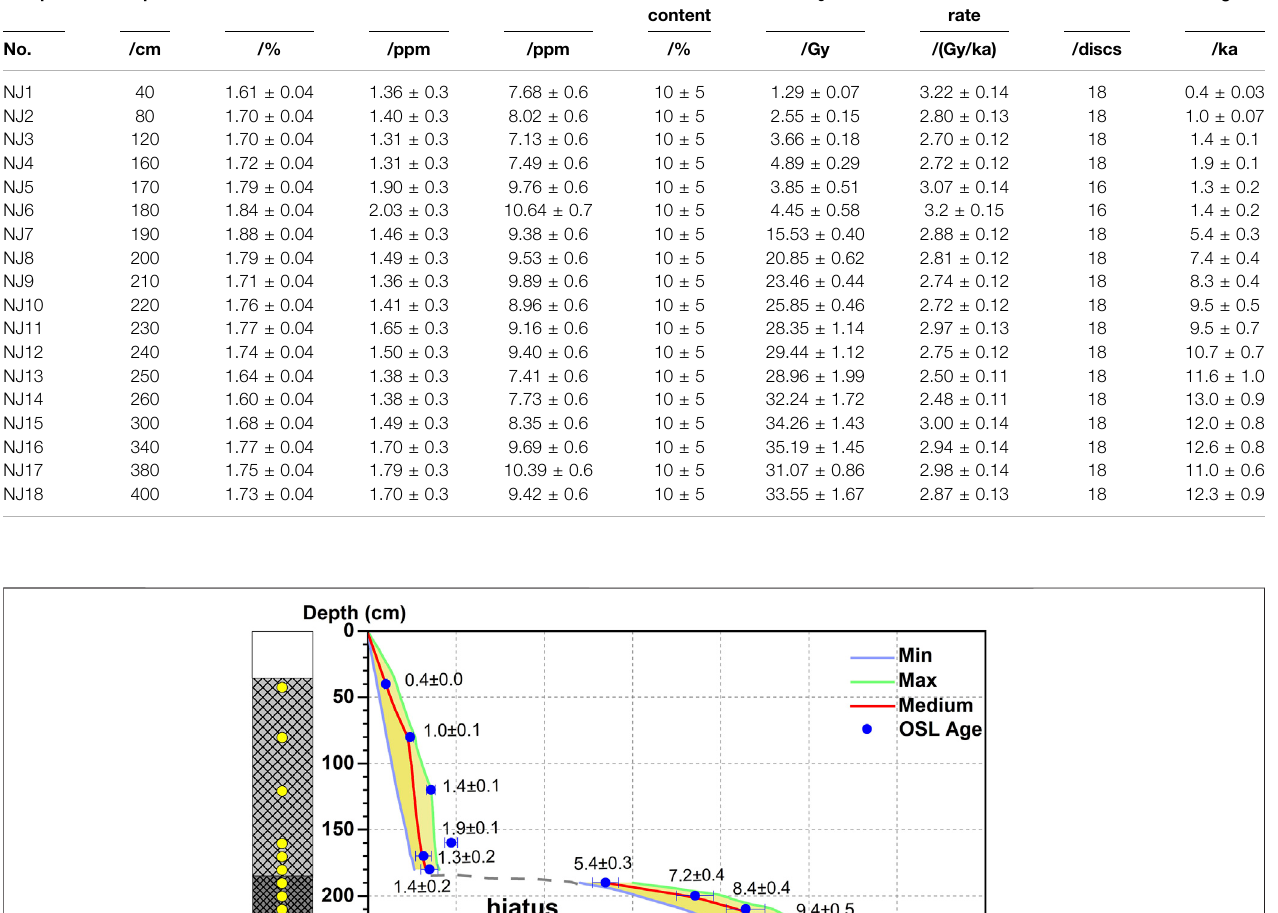
dispersion type of X-ray fl uorescence spectrometer following a routine pretreatment protocol (Liu et al., 2013a). MS was measured by a Bartington MS2 meter after drying the samples below 40 ° C.